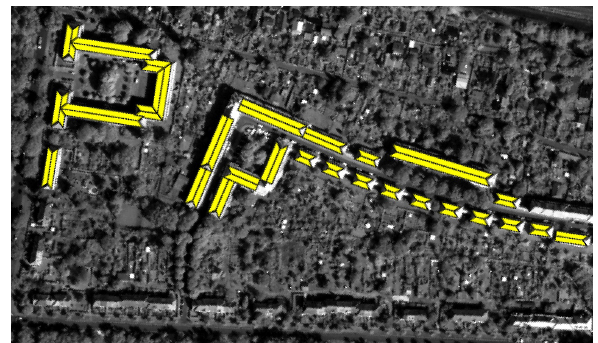
Figure 4. Selected polygons for planarity metrics evaluation overlaid on the pan-chromatic image.